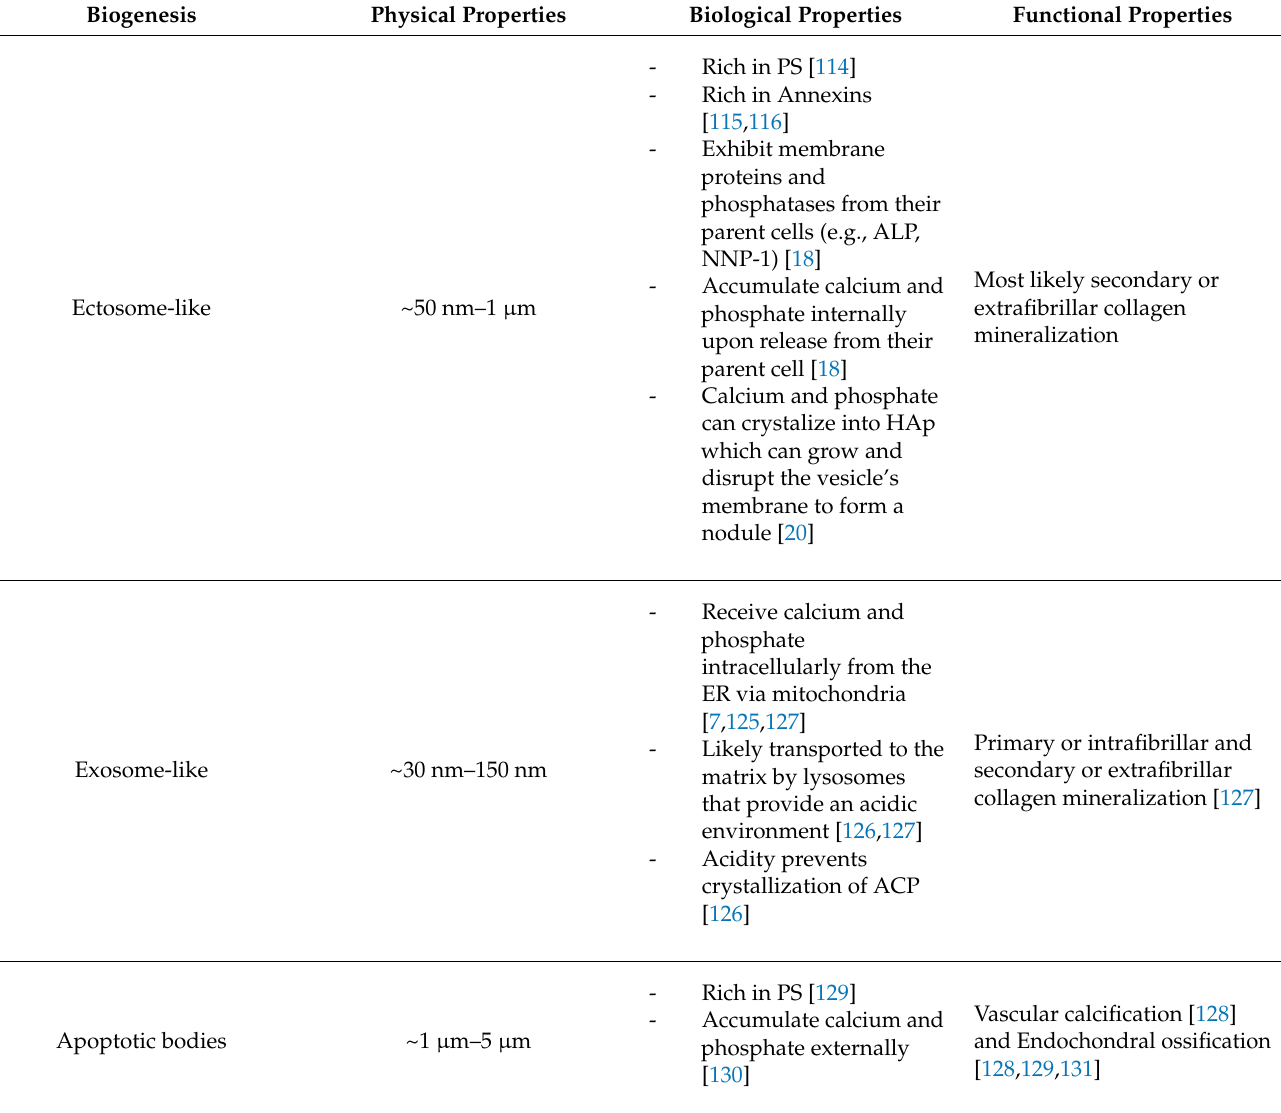
Table 2. Different types of MtVs and their physical, biological, and functional